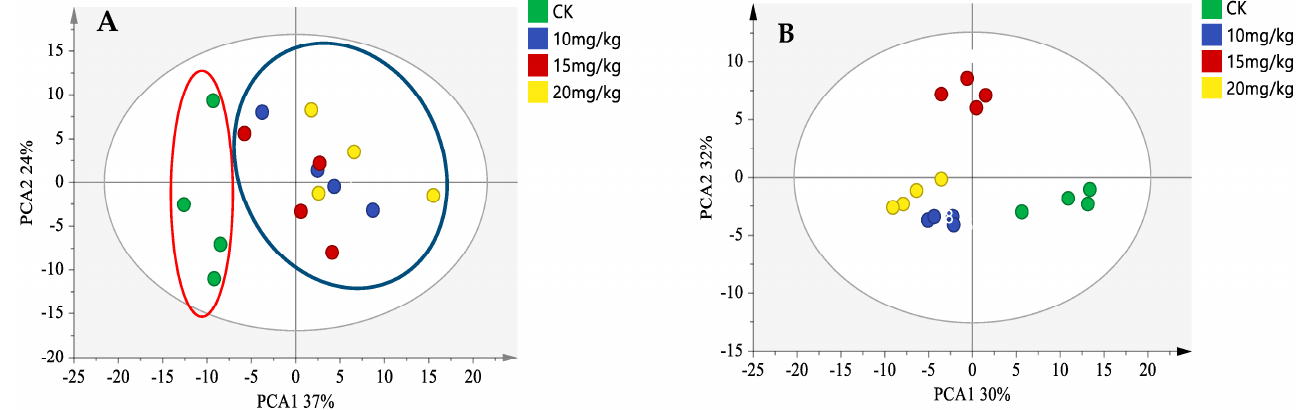
Figure 4. Score plots of the PCA model ( A ) and OPLS-DA mode ( B ) of volatile flavor compounds of fresh oriental melon after pollination or forchlorfenuron application.